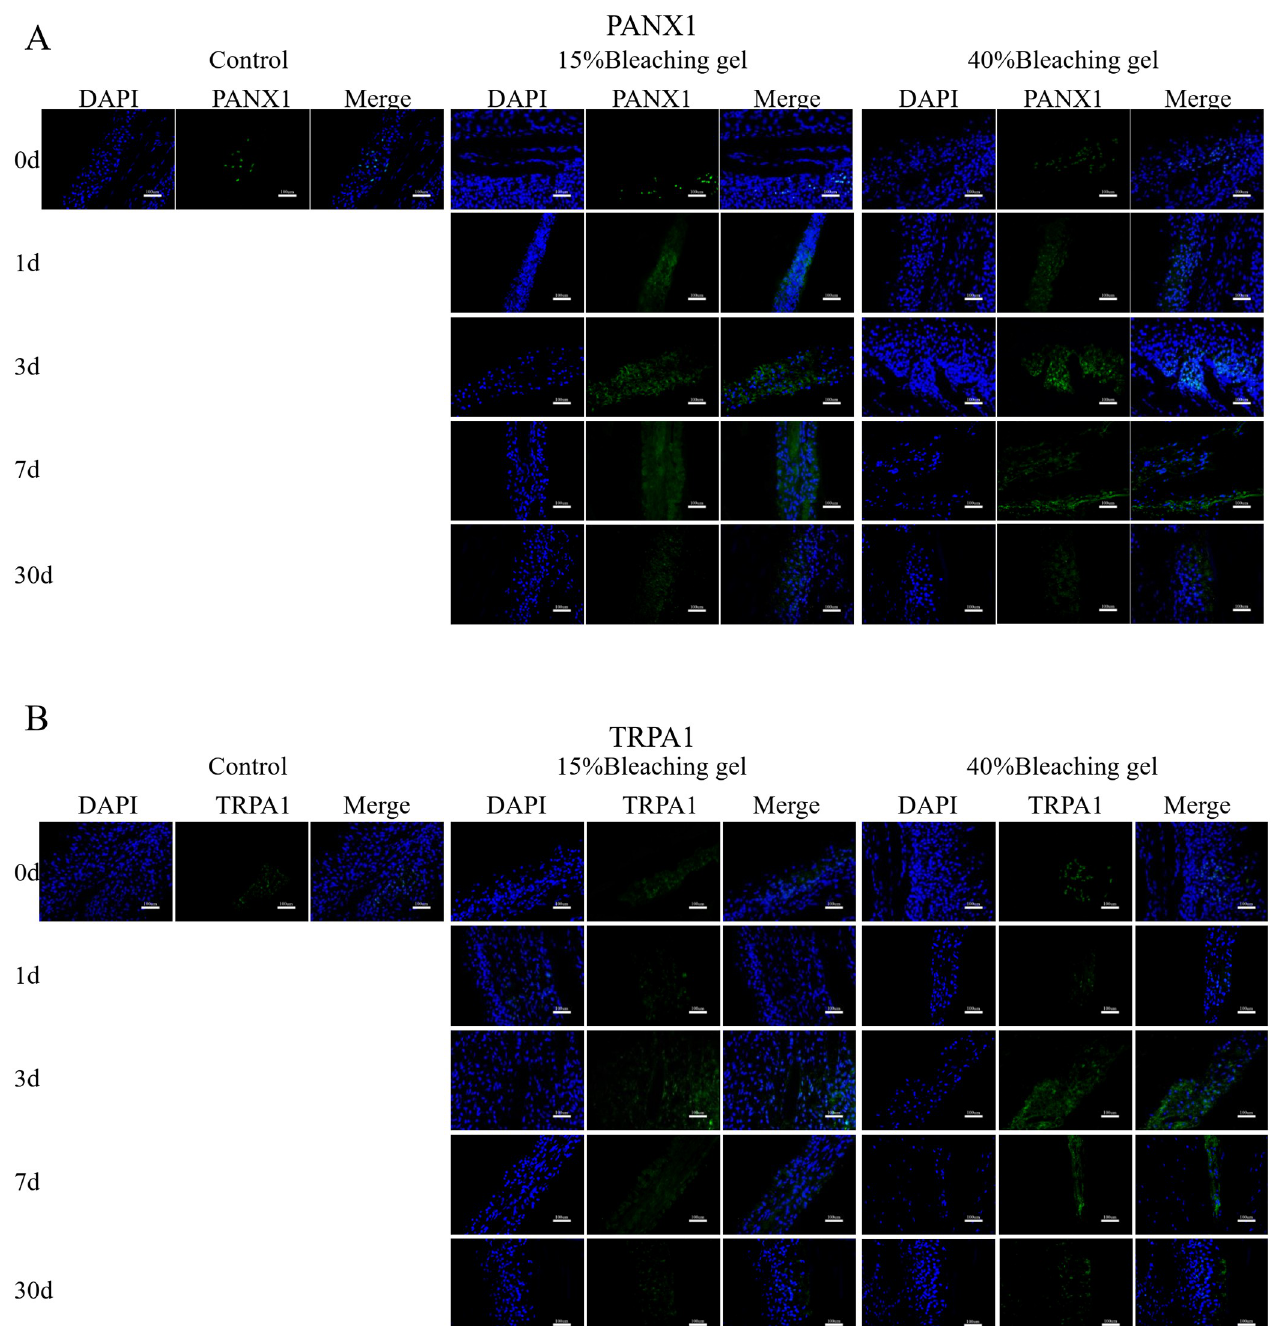
Fig 7. Immunofluorescence staining of PANX1 and TRPA1 in rat incisors after gel bleaching. Rat incisors were bleached using 15% or 40% gel for 90 or 30 min, respectively. After 0, 1, 3, 7, and 30 days, immunofluorescence staining was used to detected PANX1 and TRPA1 in the incisor pulp. The nuclei shown in blue were stained by DAPI. Bar = 100 μ m. PANX1, Pannexin1; TRPA1, transient receptor potential ankyrin 1.